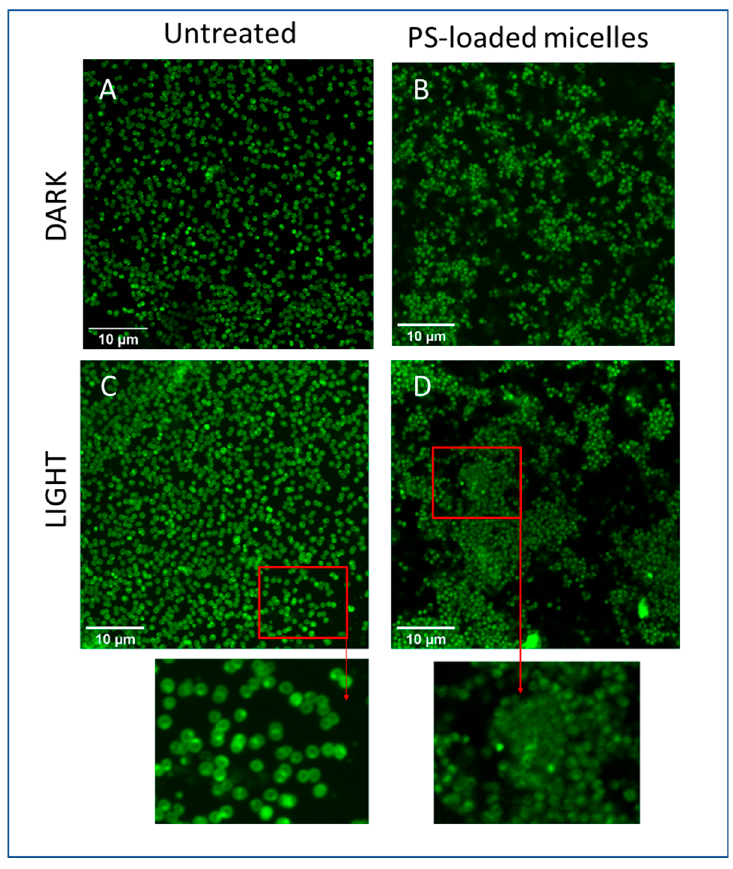
Figure 6. Photodynamic inactivation of Staphylococcus aureus grown on coverslip glasses. S. aureus cells were inoculated on coverslip glass ( A , C ) or on coverslip glass where a volume of 200 μ L of PS-loaded micelle (0.8 μ M) solutions was sprayed on ( B , D ). Upon overnight growth, cells were irradiated under light at 520 nm for 2 h ( C , D ) or dark incubated ( A , B ). The fluorochrome was added 30 m before confocal analysis. The images were acquired through a 63X objective lens and a 488 nm laser.